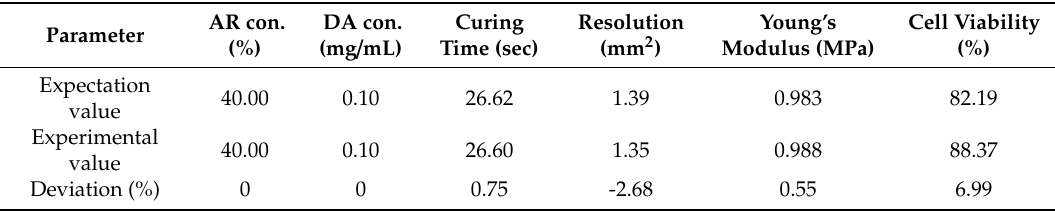
Figure 7. The images of the 3D-printed blood vessels with the optimization parameter. The blood vessels with bi-layer structure and triangle pore. Scale bar is 1 mm. Table 5. Optimization parameter verification.